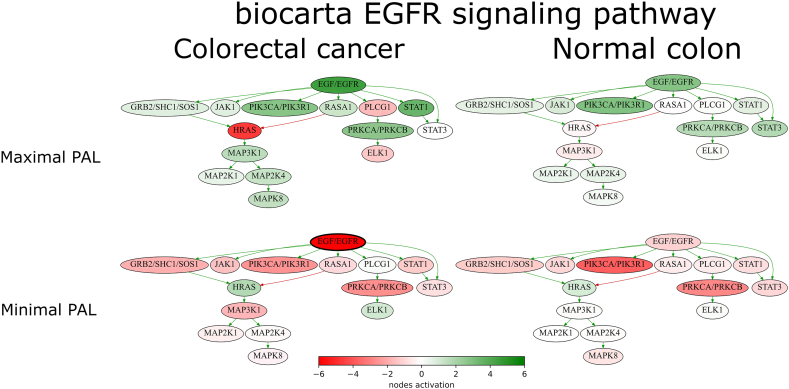
EGFR pathway (Biocarta) shown as an interacting network for samples with maximal (top) or minimal (bottom) PAL in colorectal cancer (left) vs normal colon (right). Green/red arrows indicate activation/inhibition interactions, respectively. The color depth of transcript nodes reflects the extent of node activation (logarithms of the expression fold change for each node, the reference is the geometric average between expression levels in all samples in the respective groups). Visualized using Oncobox software.